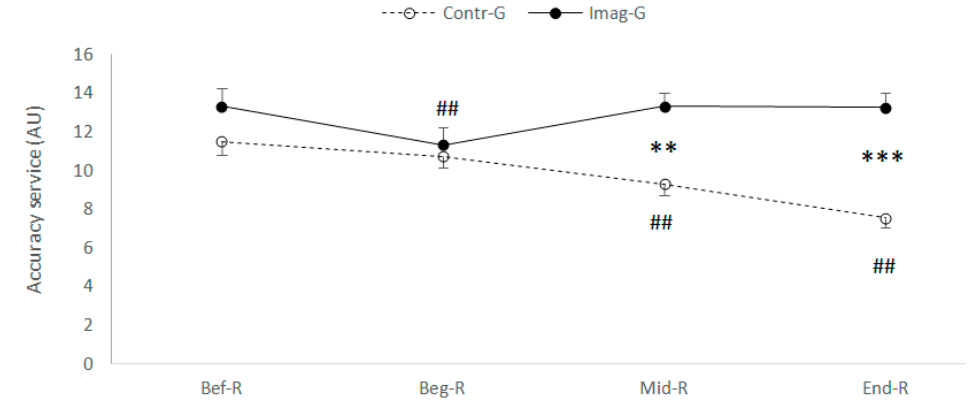
Figure 3. Mean and standard deviation of service accuracy, Before, During and at the end of Ramadan for both groups (CG vs. IMG). **, *** Significantly di ff erent from Contr-G at p < 0.01 and p < 0.001 for both groups (CG vs. IMG). **, *** Significantly different from Contr-G at p < 0.01 and p < 0.001 respectively. ## Significantly di ff erent from Bef-R at p < 0.001 respectively. ## Significantly different from Bef-R at p < 0.001 respectively.